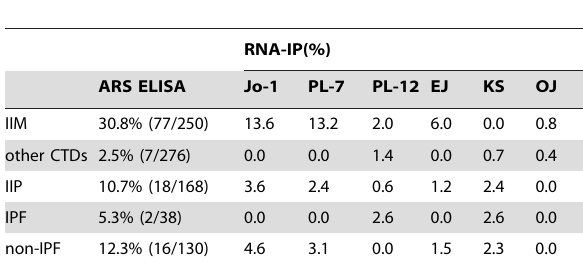
Table 2 The frequency of each anti-ARS antibody in IIM, other CTD and IIP.